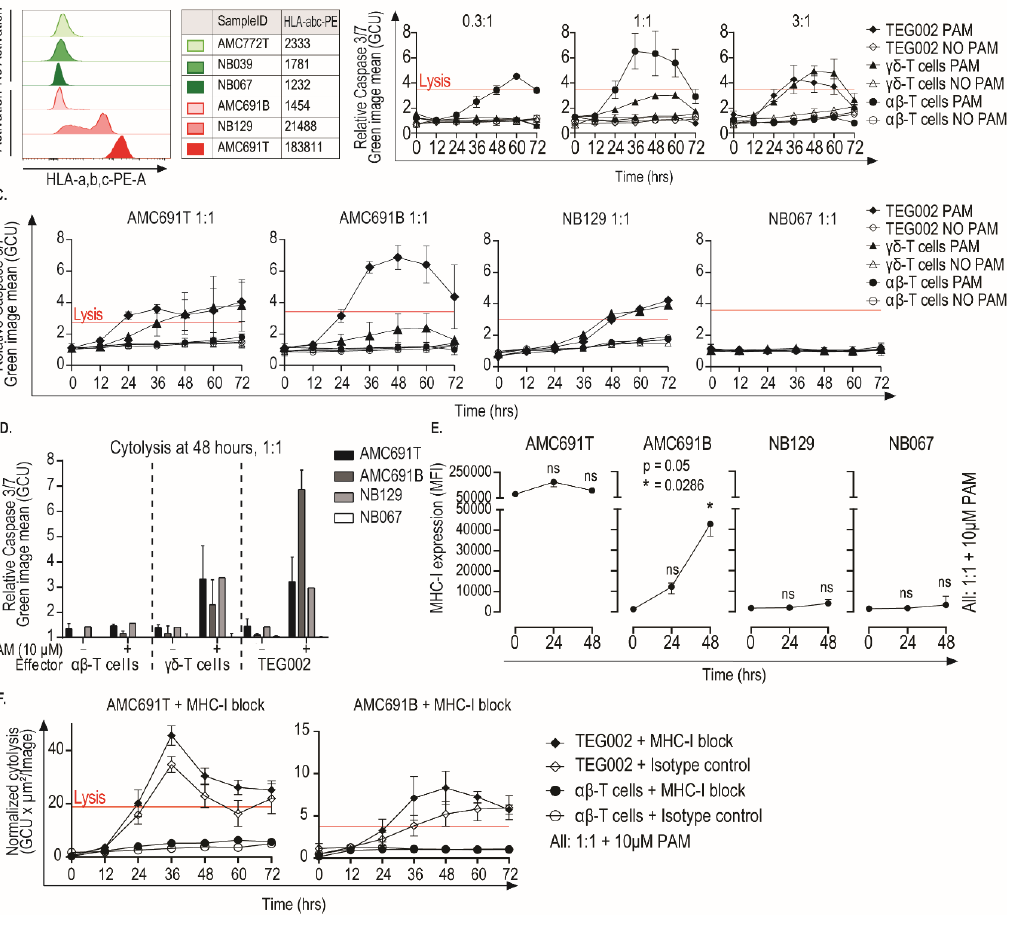
Figure 4. Neuroblastoma tumor organoids are killed by TEG002 in the presence of Pamidronate, independent of MHC-I expression. ( A ) Expression of HLA-a,b,c of all six organoids, measured by flow cytometry. Green indicates “No Activation” and red indicates “Activation” of TEG002. ( B ) Detailed dynamics of AMC691B killing by TEG002 over time. Representative graphs of one effector donor, which was tested in three different E:T ratios, are shown. Red line indicates the maximal cell lysis induced by the lysis control. ( C ) Killing of all four organoids by TEG002 over time at a 1:1 E:T ratio. AMC691T, AMC691B, and NB067 were tested with effectors from two different donors and NB129 with effectors from one donor. Graphs show mean of all experiments. ( D ) Bargraph of cytolysis at 48 h. Only the 1:1 E:T ratio is shown here. ( E ) Expression of HLA-a,b,c on four selected organoids in co-culture setting, measured by flow cytometry. Median Fluorescence Intensity (MFI) of HLA-a,b,c was used. Flow cytometry was performed only on organoids in co-culture with TEG002, with the addition of PAM at E:T 1:1. A Friedman test and a Dunn’s post hoc test, in comparison to T = 0, were performed to determine significant upregulation. ( F ) Cytolysis of AMC691T and AMC691B by TEG002 and untransduced αβ -T cells in the presence of 10 μ g/mL MHC-I blocking antibody (clone W6/32, Bio-Techne, supplementary Figure S3) or isotype control. Lysis control = Puromycin (1 μ g/mL); PAM = Pamidronate; E:T = Effector to Target; all data are normalized to the target only condition; lysis control at 24 h.